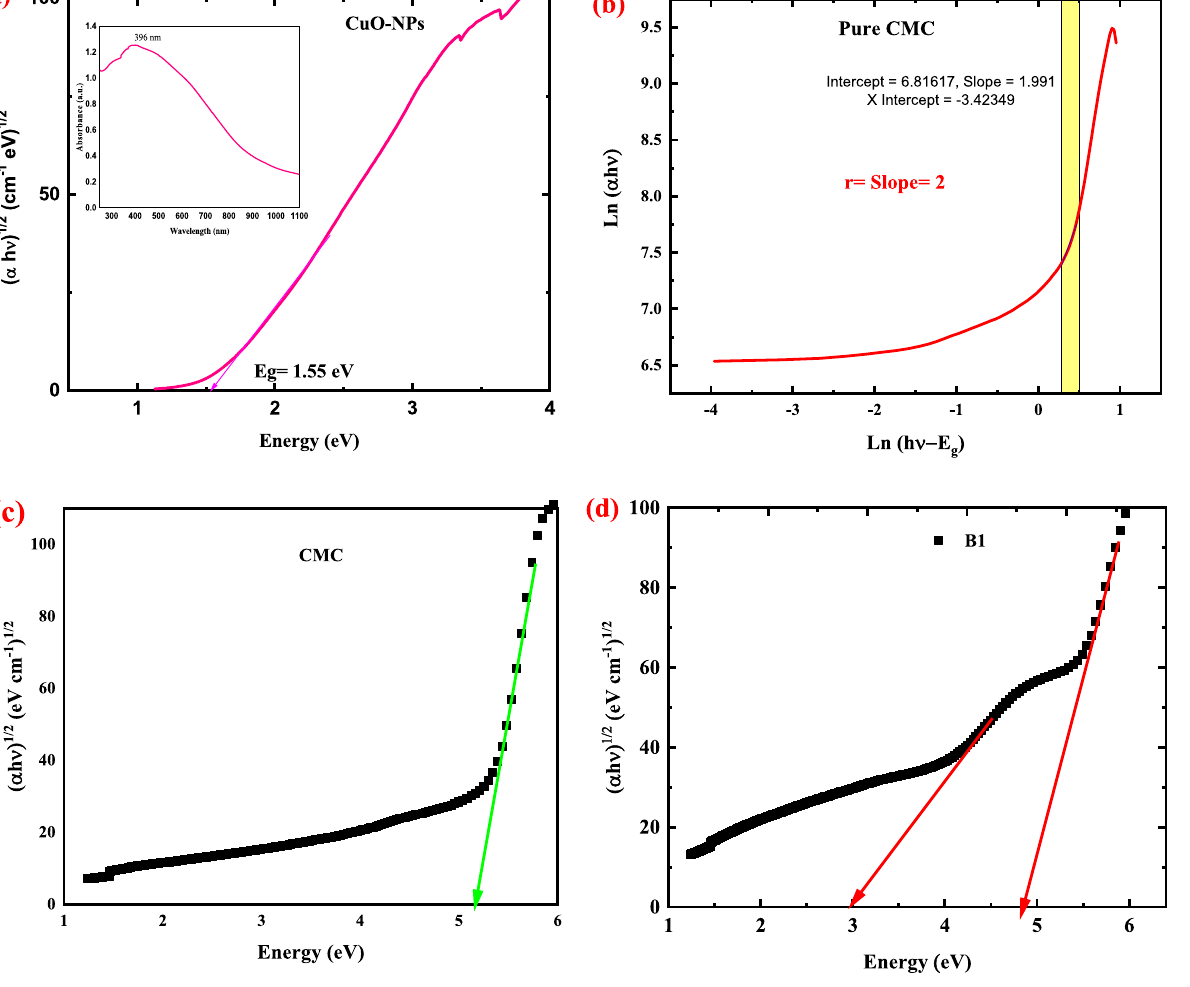
Figure 6. ( a ) variation of (αhν) 2 of CuO- NPs versus photon energy together with the absorption spectra of CuO-NPs in the inset of the figure ( b ) plot of ln (αhυ) versus ln (hυ-E g ) for pure CMC and ( c: g ) presents the plot of (αhν) 1/2 versus hν for pure CMC and CMC doped with 2, 4, 6 and 8 wt. %